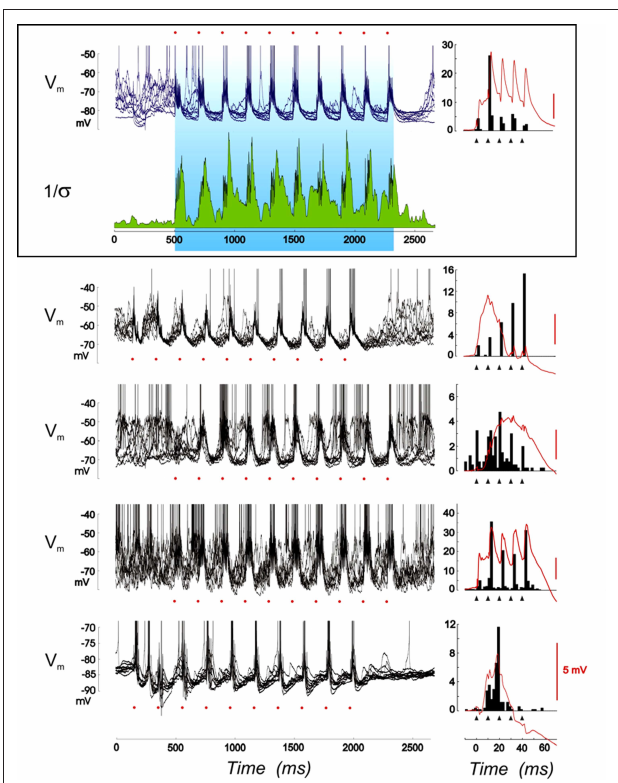
Figure 4 | Changes of covariance between pre- and postsynaptic activities imposed during theta-burst. For each of the five cells presented, the voltage traces are synchronized with the onset of each theta-burst train and repetitions are overlaid. The reproducibility of the recorded waveform, shown for the first cell only (inset, second row from the top), is high, especially in-between the high frequency bursts, whose individual onsets are underlined by red dots. The variability reduction in the Vm dynamics is quantified by the inverse of the standard deviation ( σ ) of the waveforms computed over the 25 TBS repetitions (1/ σ index, green plot) and shown with the voltage waveform for one of the cells (top inset). In the right column, the mean voltage waveform (in red) synchronized with each burst onset is shown for the duration of the burst and overlaid with the mean spike pattern imposed by the high frequency volley (black filled histogram). Black filled triangles show the occurrence of individual electrical thalamic